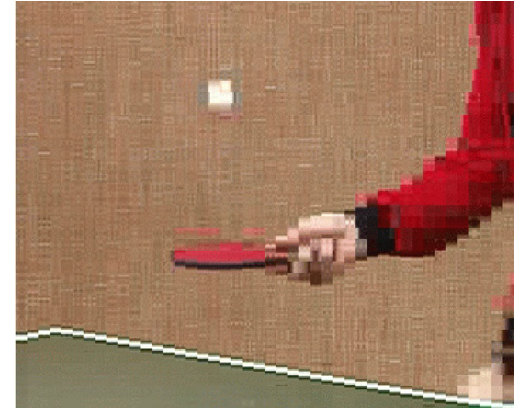
Figure 16: Both DCT algorithms were used to code this frame. Af- ter block classification, the ChoLee-DCT was used to code blocks where no edges were detected and the AAN-DCT for blocks with detected edges.